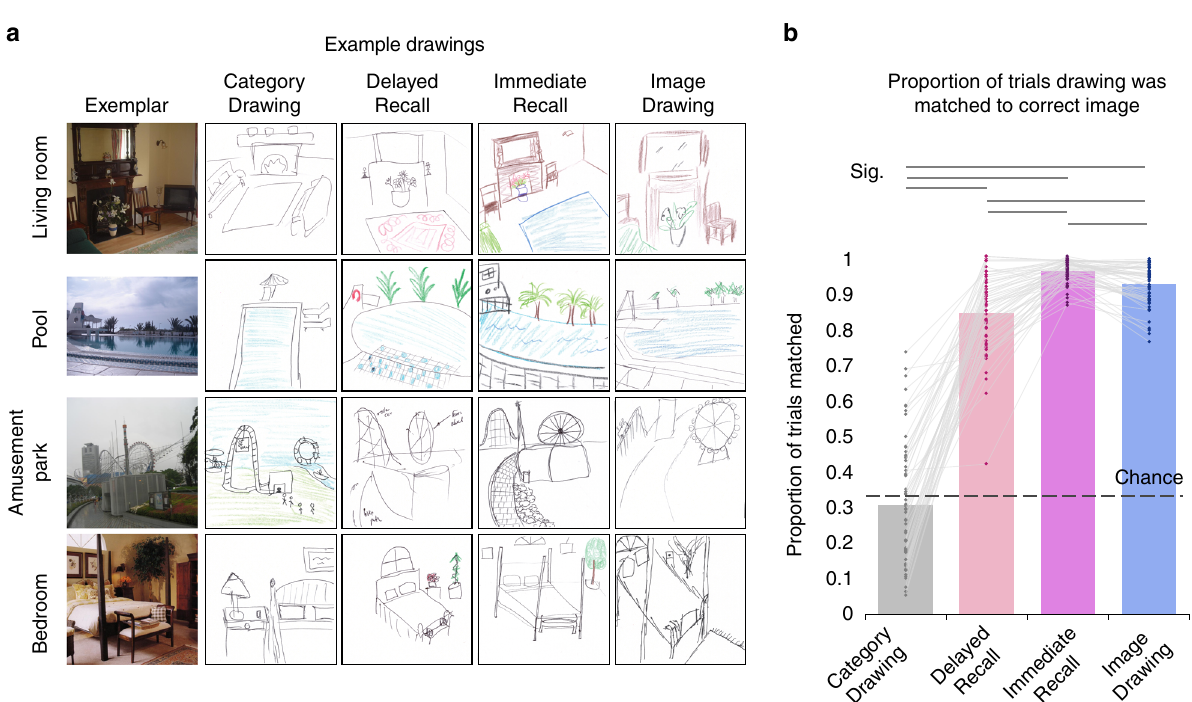
Fig. 1 Example drawings and drawing matching performance. a Example drawings made from Category Drawing, Delayed Recall, Immediate Recall, and Image Drawing conditions for four exemplars from the 30 image categories (see Supplementary Figure 1 for examples from all 30 categories). Both Delayed Recall